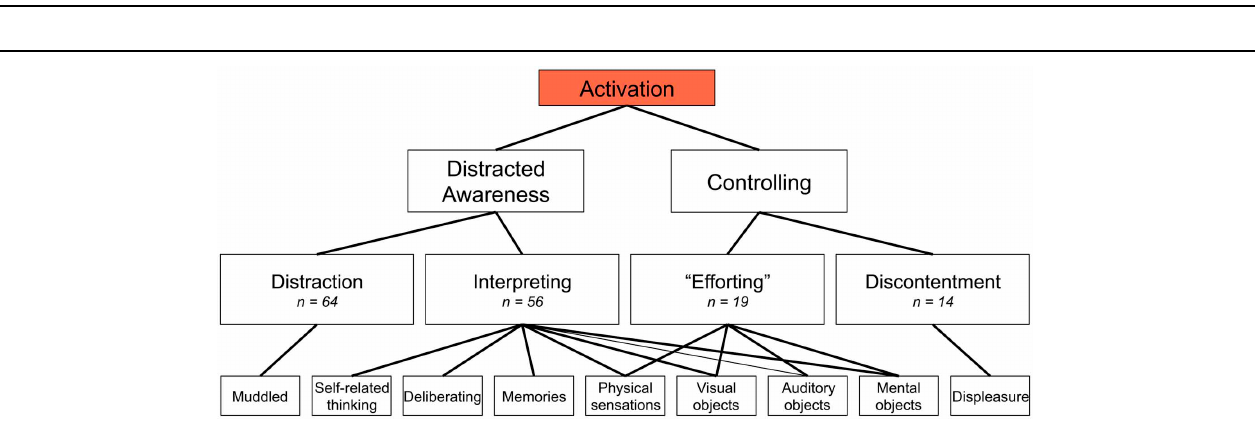
FIGURE 2 | Phenomena of the subjective experience of meditation related to posterior cingulate cortex deactivation ( n = number of occurrences in self-reports).